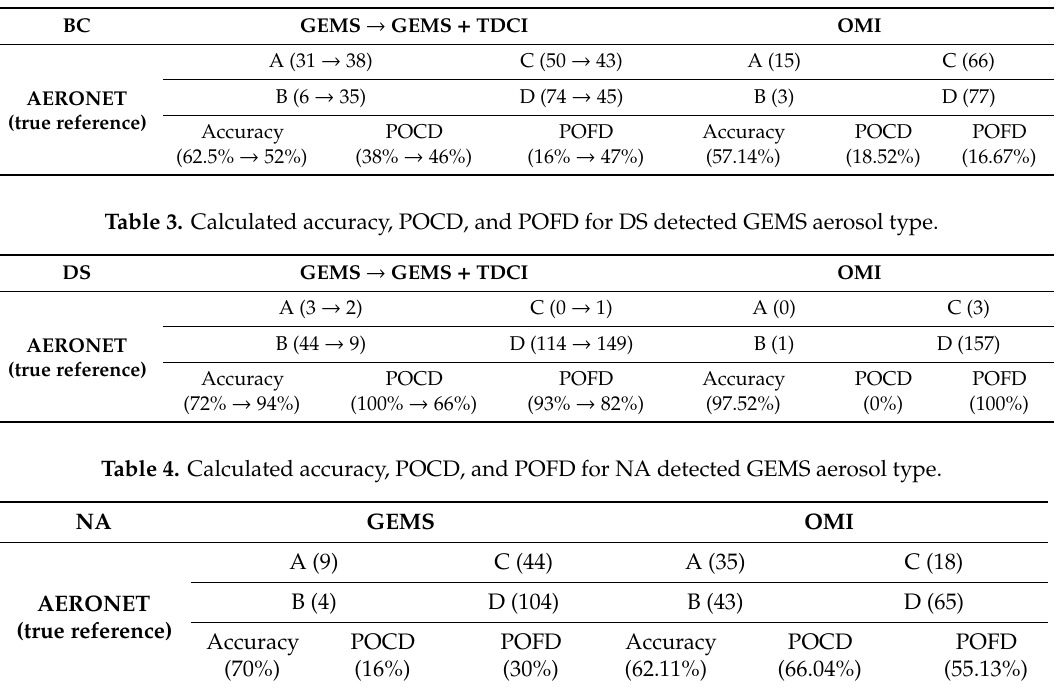
Table 2. Calculated accuracy, probability of correct detection (POCD), and probability of false detection (POFD) for BC detected GEMS aerosol type.